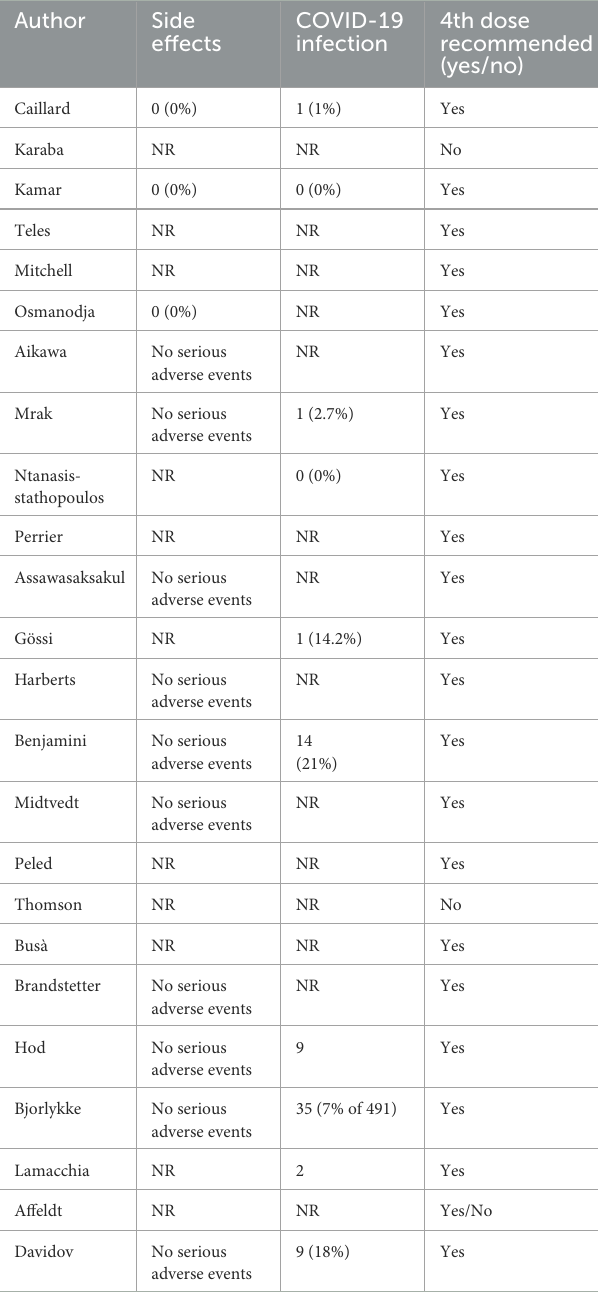
TABLE 6 Clinical outcomes after 4th dose of